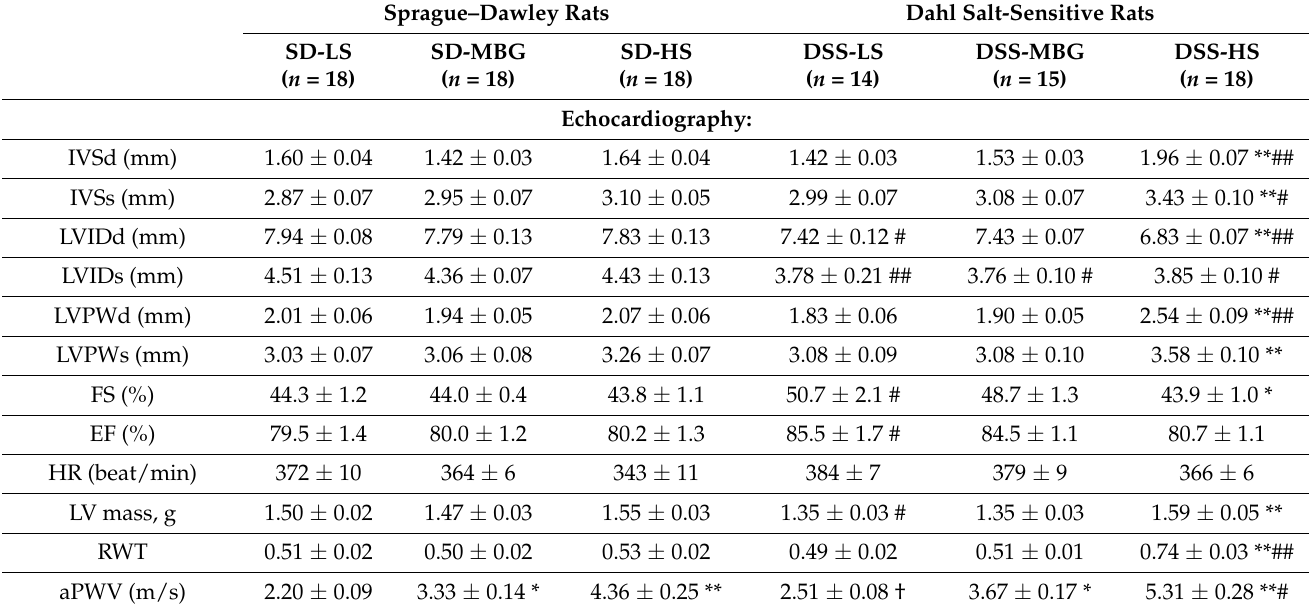
Table 2. Echocardiography parameters and tissue weights in Sprague–Dawley rats and Dahl salt-sensitive rats following low-salt (LS) diet, marinobufagenin (MBG) or high-salt (HS) diet